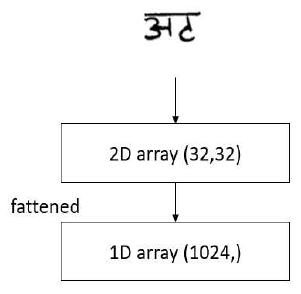
Fig. 4. Image Pre-processing